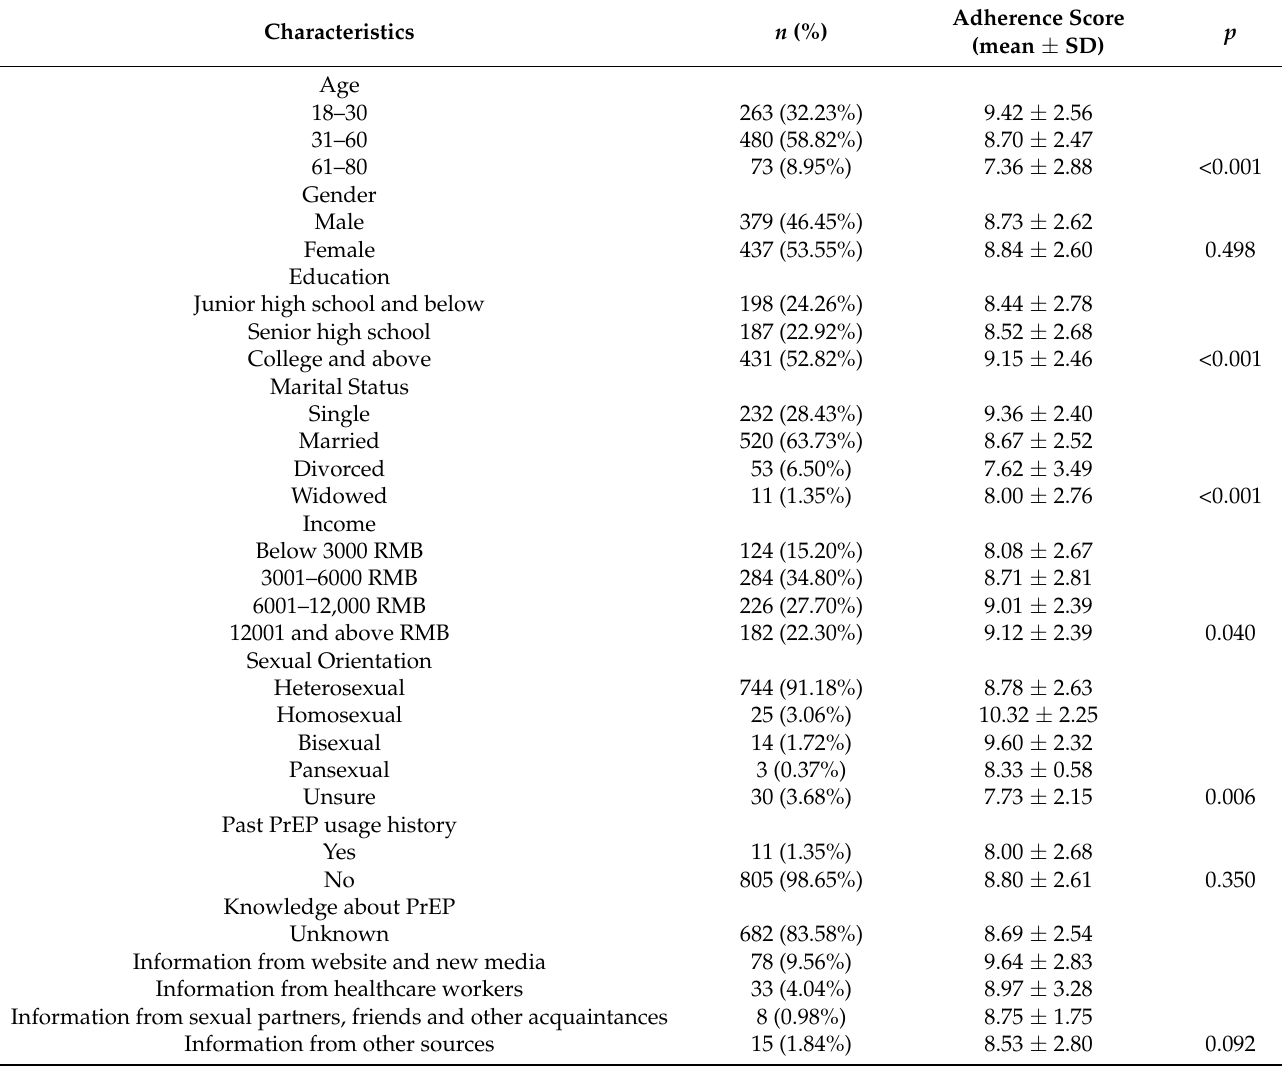
Table 1. Participant demographic and adherence-related characteristics.